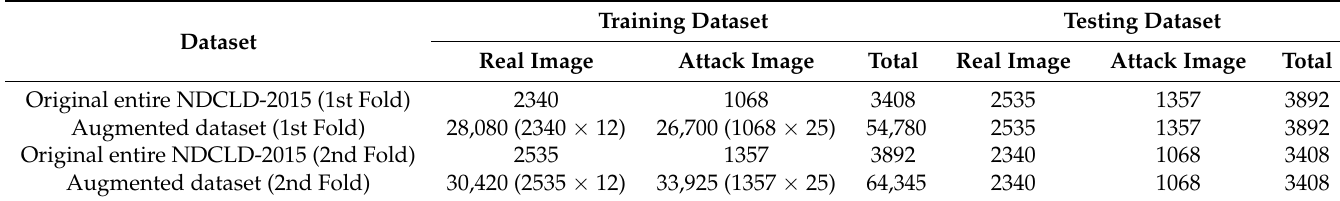
Table 9. Description of training and testing datasets of NDCLD-2015 dataset using our second division